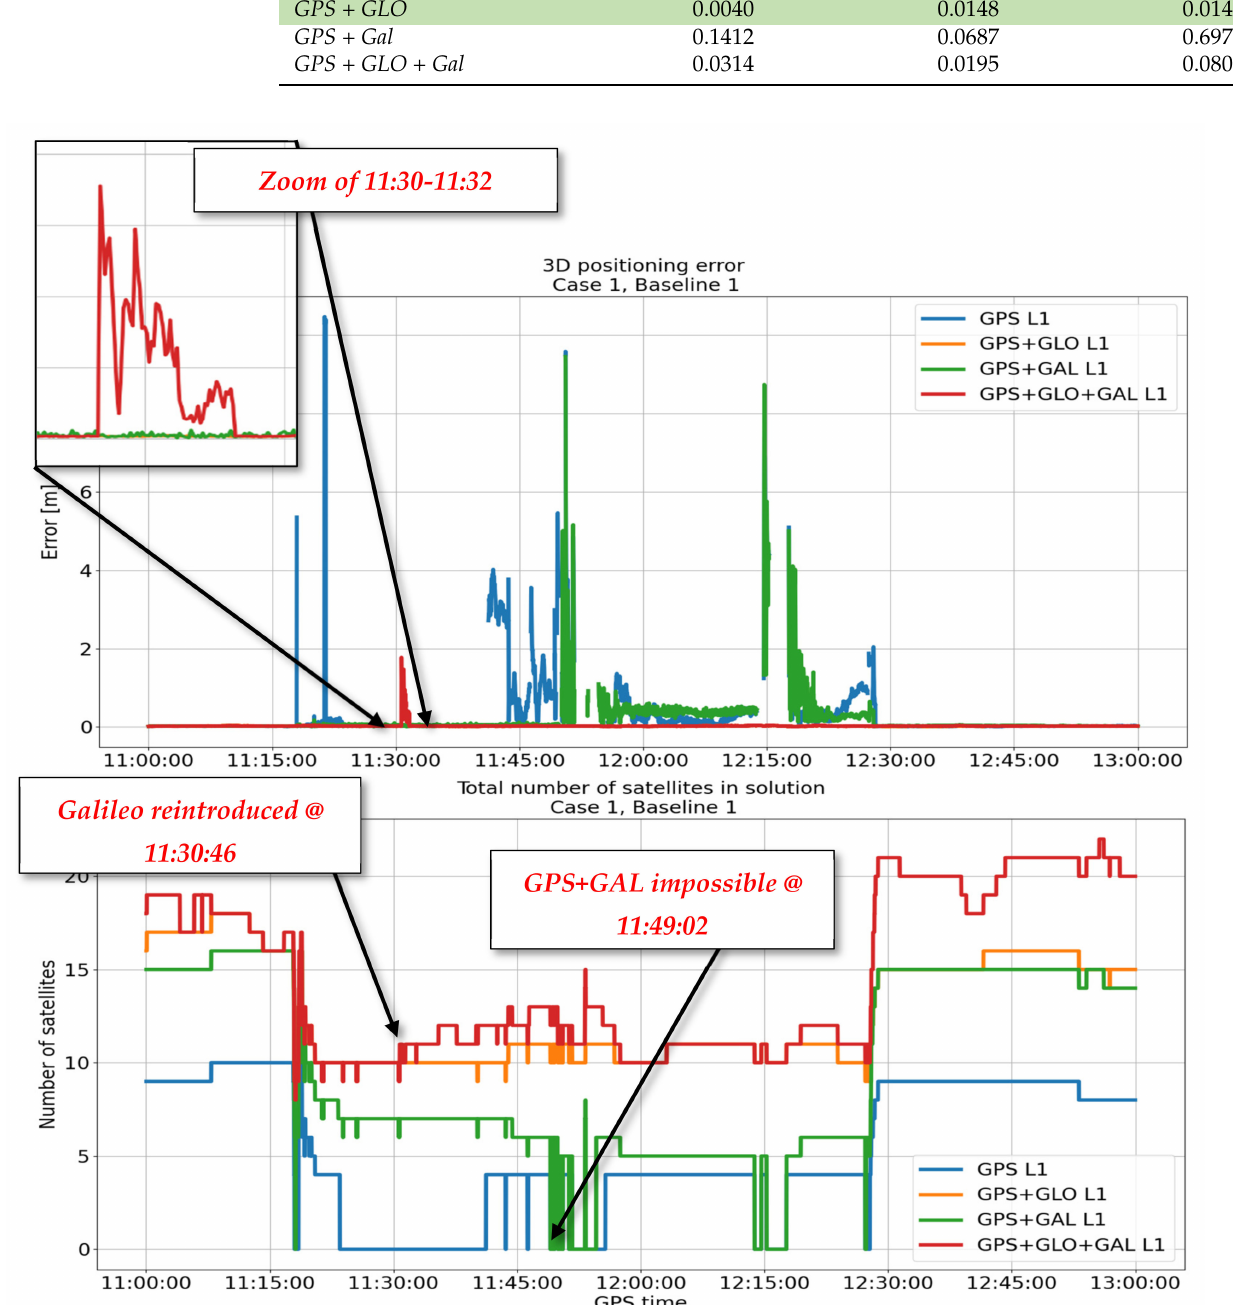
Figure 10. Solution 3D error ( top ) and number of satellites in the solution ( bottom ) for various L1 only solutions to Case 1, baseline 1 (11 km). Timestamps on the bottom plot refer to the following events: 11:30:46: Re-inclusion Galileo satellite in the 3CS after it has reverted to a GPS + GLO solution at the start of the jamming incident—consequences for the positioning solution are shown in the zoom on the top plot.11:49:02: Owing to signal tracking being prevented, a GPS + GAL solution becomes